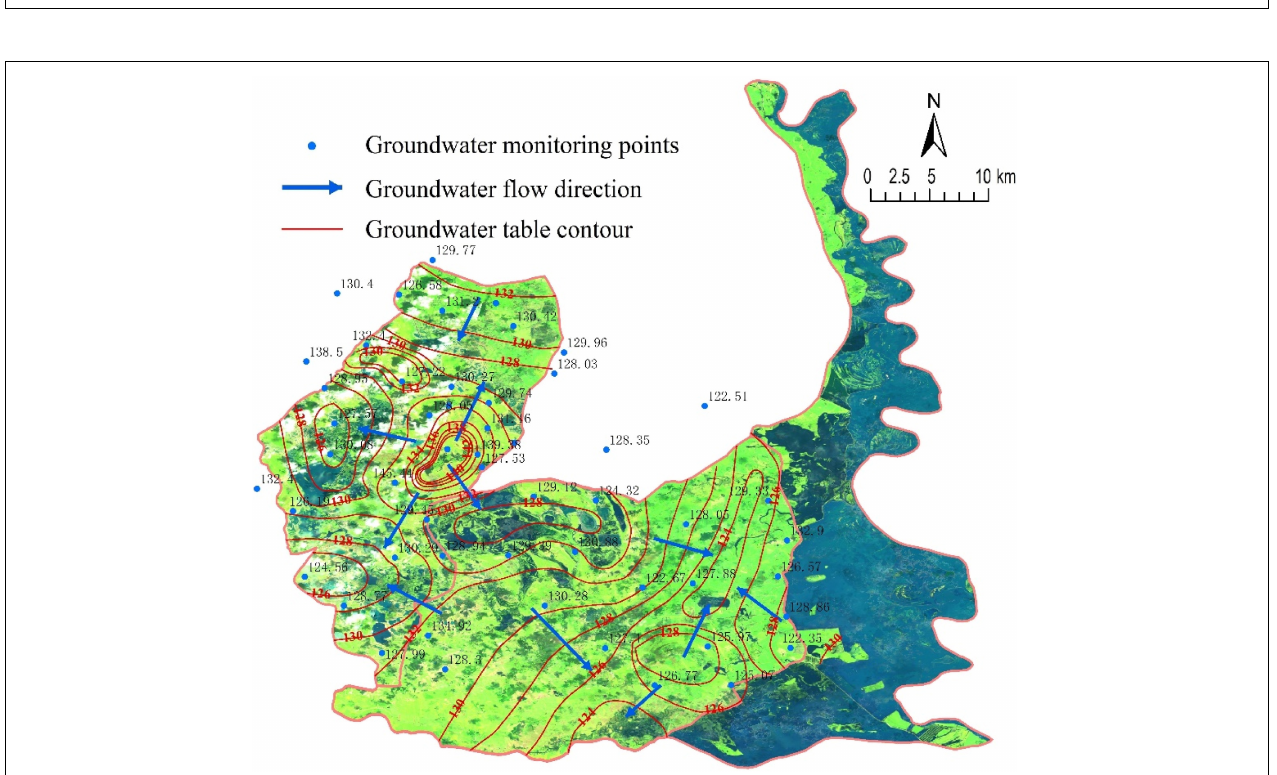
FIGURE 7 | Groundwater table contour in June 2019 (a.m.s.l).